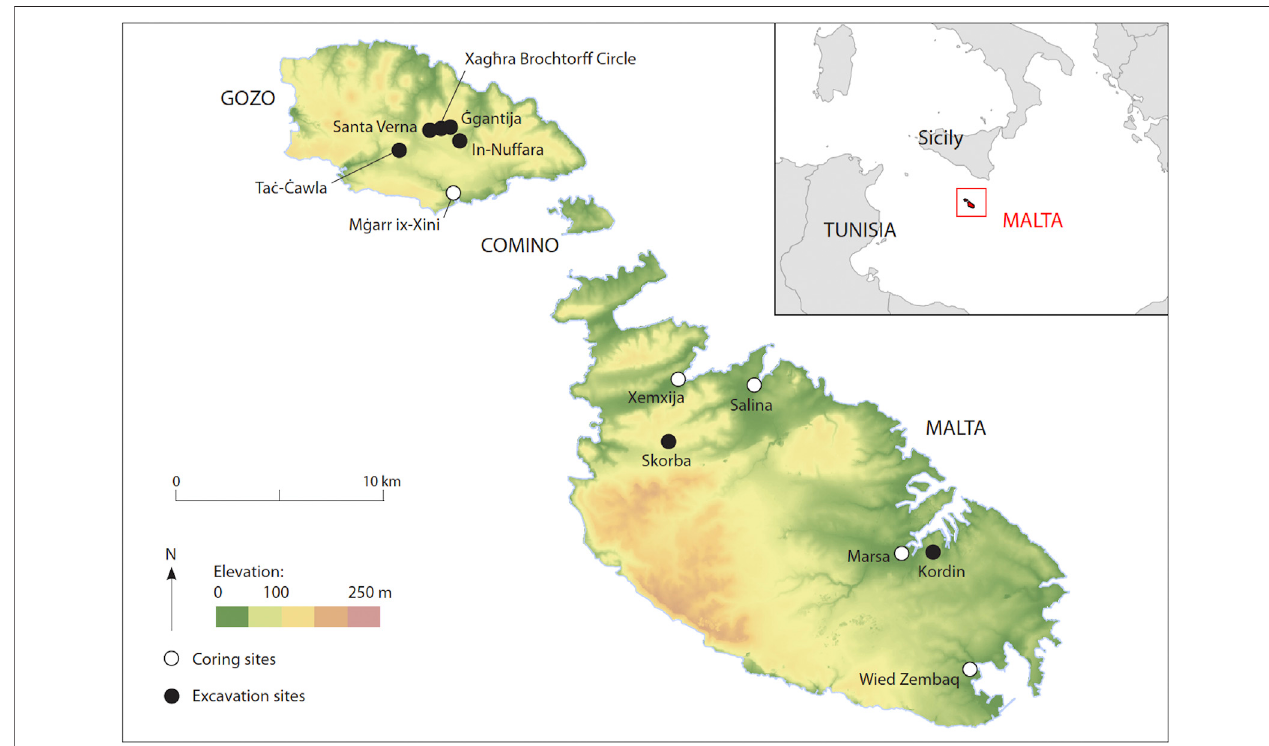
FIGURE 1 | Map of key archaeological sites and palaeoenvironmental coring sites (reproduced from Malone et al., 2020b; CC-BY-ND licence).